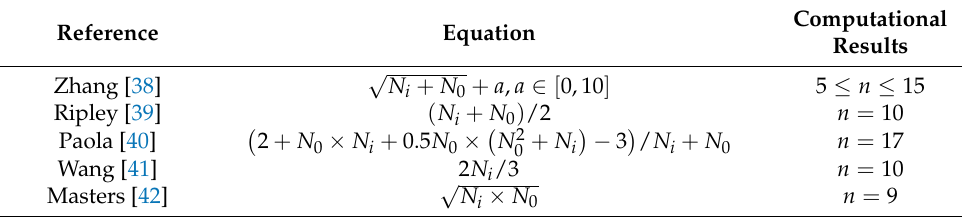
Table 3. Empirical formulas of the neural network structure.